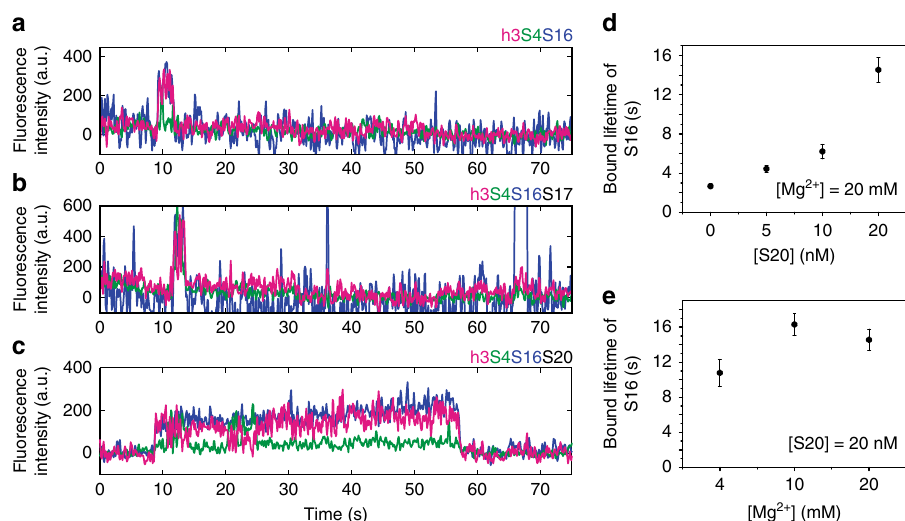
Fig. 3 Lifetime of S16 binding depends on the composition of preassembled RNPs. a – c Examples of three-color fl uorescence traces showing S16 binding in the presence of a S4, b S4 + S17 (20 nM), and c S4 + S20 (20 nM). These reveal the short lifetime of bound S16 when S20 is missing from the primary assembly complex. Fluorescence intensities are from S16-Cy3 ( blue ), S4-Cy5 ( green ), or h3-Cy7 ( magenta ) upon excitation of Cy3. The intensity jumps when S16-Cy3 localizes at immobilized preassembled 5 ′ domain RNPs. Anti-correlated fl uctuations of Cy7 and Cy5 intensities indicate that 16S h3 remains dynamic after S16 binding. d Average lifetime of bound S16 vs. S20 concentration, in 20 mM MgCl 2 . Each measurement is based on 75 – 154 molecules. Error bars indicate the s.e.m. from triplicate measurements. e Average lifetime of bound S16 vs. Mg 2+ concentration with 20 nM S20, as in d . Each measurement is based on 68 – 105 molecules. The lifetime of S16 binding strongly depends on the presence of S20 but not on the Mg 2+ -dependent stability of the RNA